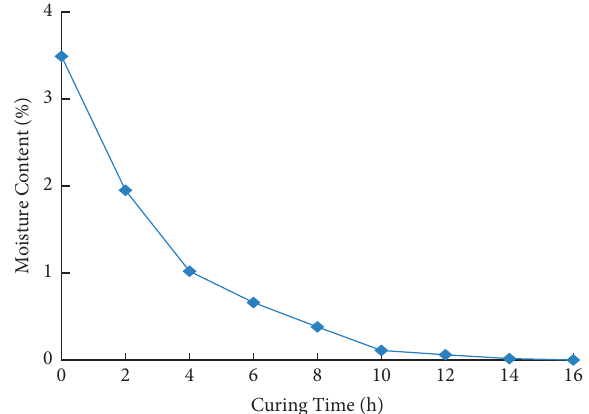
Figure 9: Change of moisture content with curing